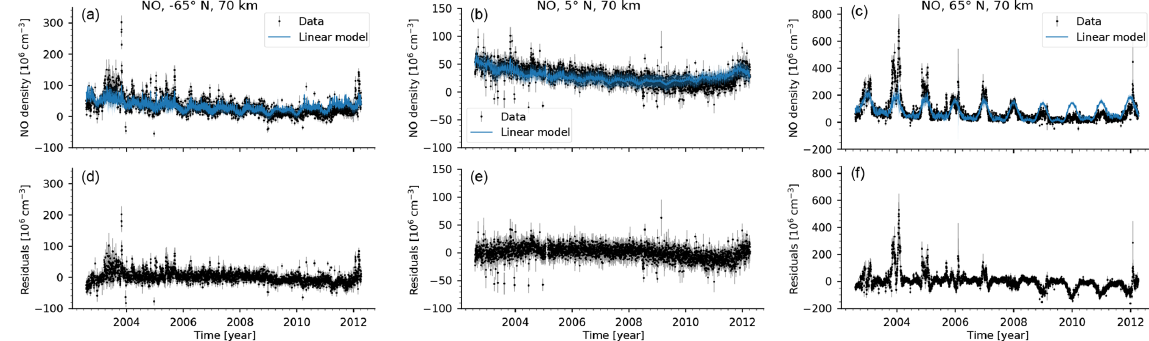
Figure 1. Time series data and linear model values and residuals at 70km for 65 ◦ S (a, d) , 5 ◦ N (b, e) , and 65 ◦ N (c, f) . Panels (a) – (c) show the data (black dots with 2 σ error bars) and the model values (blue line). Panels (d) – (f) show the residuals as black dots with 2 σ error bars.